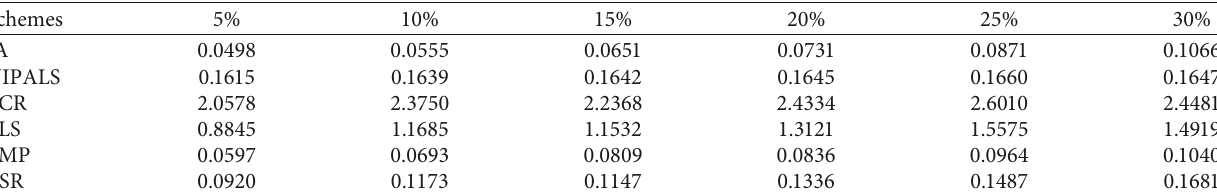
Table 5: Cost of imputation